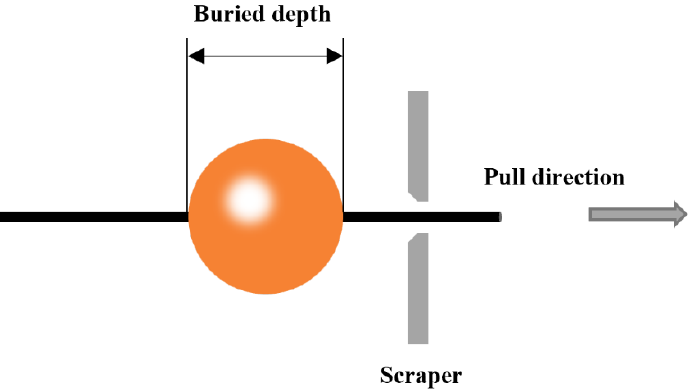
Figure 3. Experimental schematic of the single-microsphere debonding test.